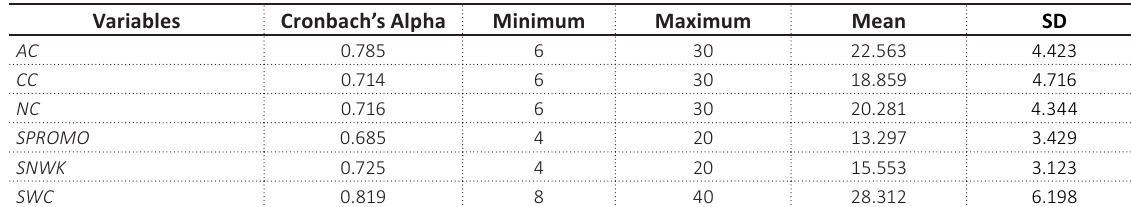
Table 1. Summary statistics